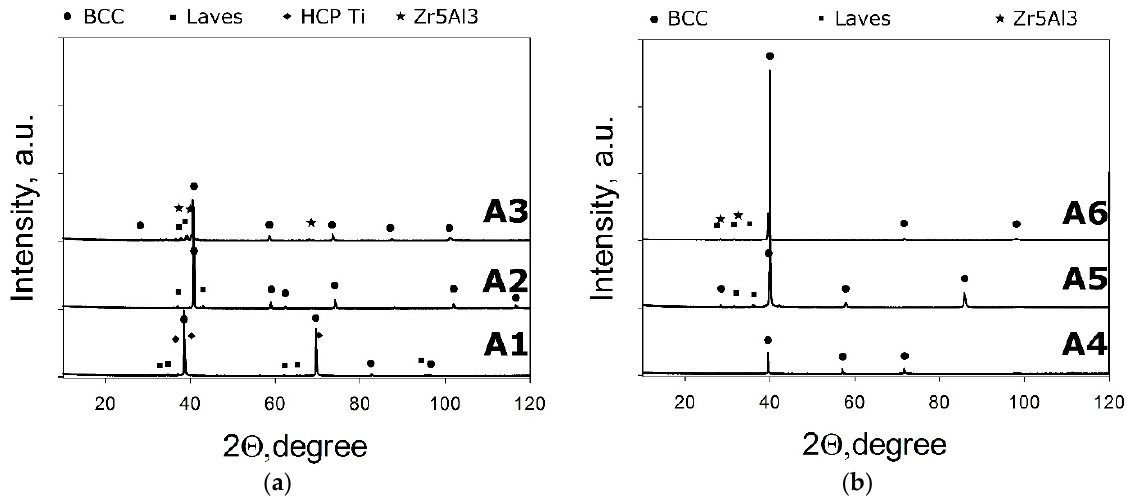
Figure 9. XRD patterns of the A1–A3 ( a ) and A4–A6 ( b ) model alloys. Microstructures of the model alloys are shown in Figure 10. SEM images of all alloys demonstrate multiphase structures. Microstructures of the alloys A2 and A4 consist of grains ~100–200 µ m in size with second phase(s) precipitations located mainly along grain boundaries. In the A4 and A2 alloys the second phase particles create a continuous intergranular layer with the thickness from 0.6 µ m (in A4) to 4.8 µ m (in A2). The volume fraction of the secondary phases was ~1% in A4 and ~27% in A2. The alloys A1, A3, A5 and A6 rather have a dendritic microstructure with second phase(s) located in the interdendritic areas. In the A1, A3, and A5 alloys, the second phase(s) are mostly presented as separate particles while in A6 the second phase creates a continuous network. The volume fraction of the second phase(s) was ~6% in A1, 41% in A3, 10% in A5 and 7% in A6. Chemical compositions of the phases in the model alloys are shown in Table 3; a more detailed investigation of microstructures was out of the scope of the present work. For four of the six model alloys, the amount of the second phase(s) was less than 10%. However, differences between the measured phase compositions (Table 3) and CALPHAD calculations were more pronounced. For the alloys A4 and A5, the content of the second phase was small and therefore the peaks of the second phase was not observed in the X-ray diffraction pattern. For A2 the calculated phase composition corresponded to the actual one only qualitatively. Some discrepancies between the calculated phase composition and the actual one was observed in A3. Meanwhile, for the A1 alloy, one can notice the presence of a phase that was not calculated in the CALPHAD